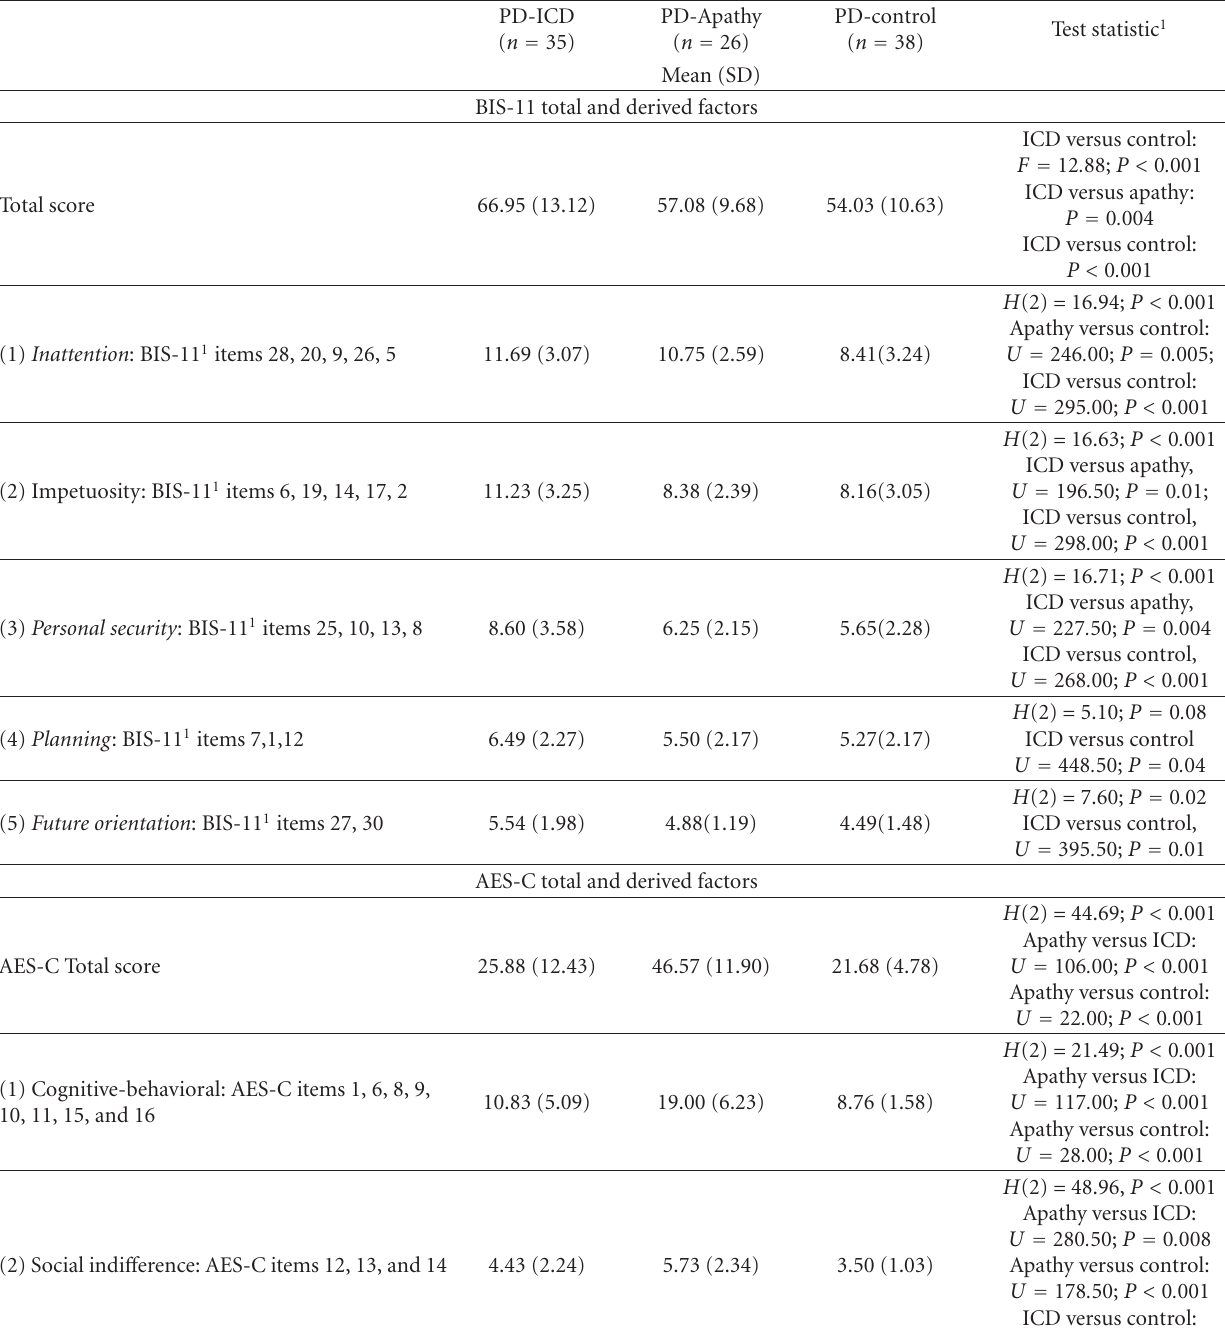
Table 3: Comparison of mean (SD) Barratt Impulsiveness Score, and Apathy Evaluation Scale, Clinician Version factors across the three behavioral